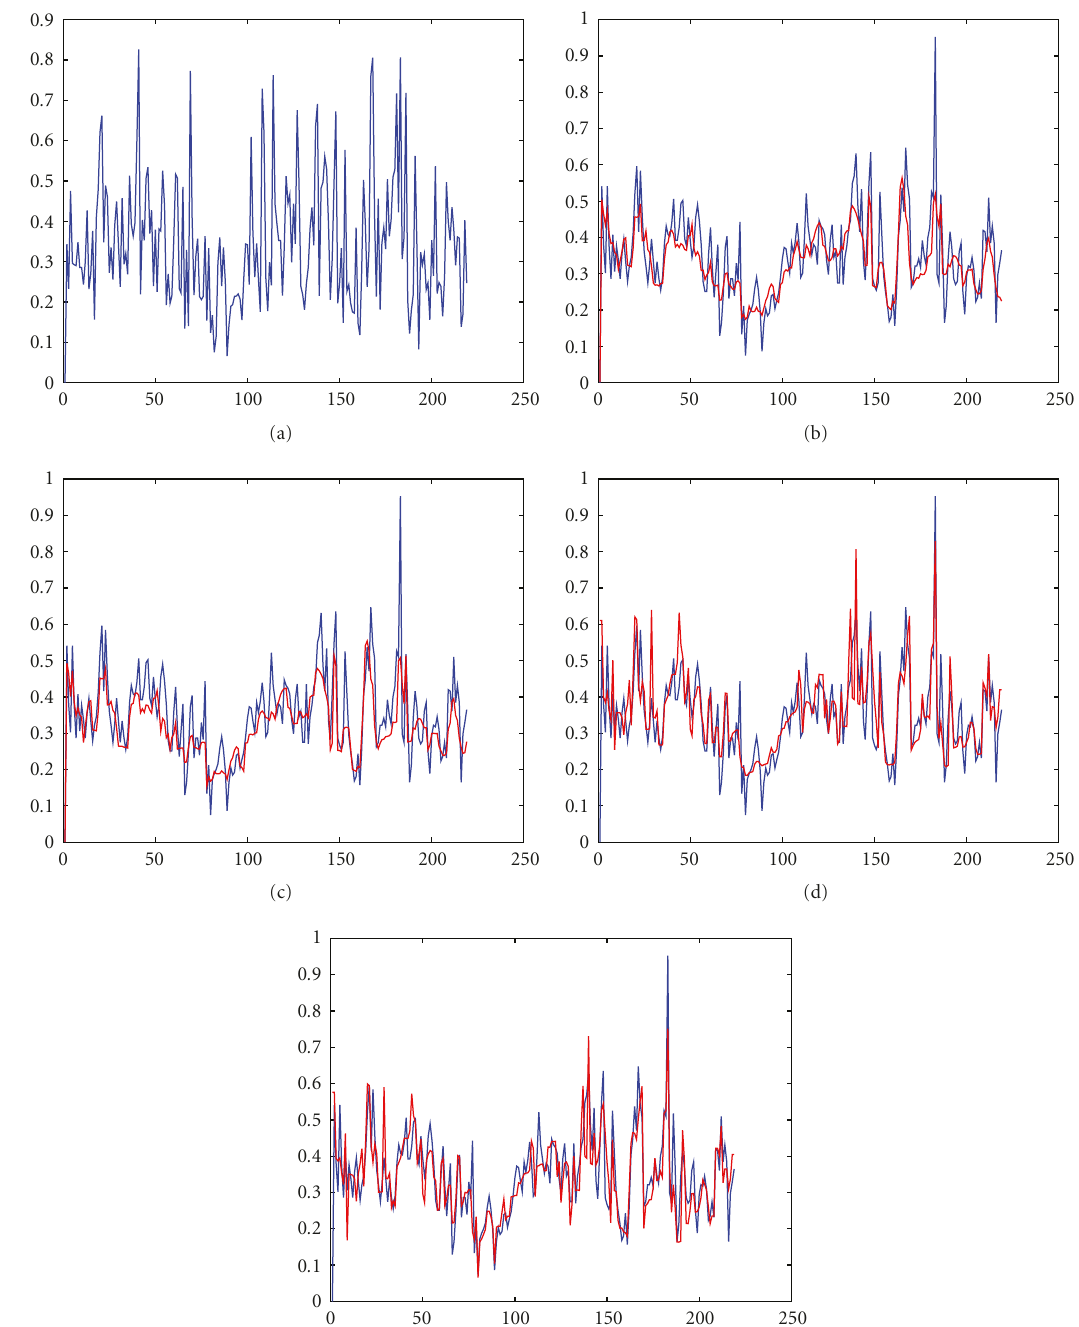
Figure 11: The 128th line of the original, noisy, and restored images for denoising Figure 3(b). (a) The noisy image; (b) the slice restored by the proposed method; (c) the slice restored by the “HMW” method; (d) the slice restored by the “AA” method; (e) the slice restored by the “RLO” method. Here the blue line is the original image, and the red line is the restored image.